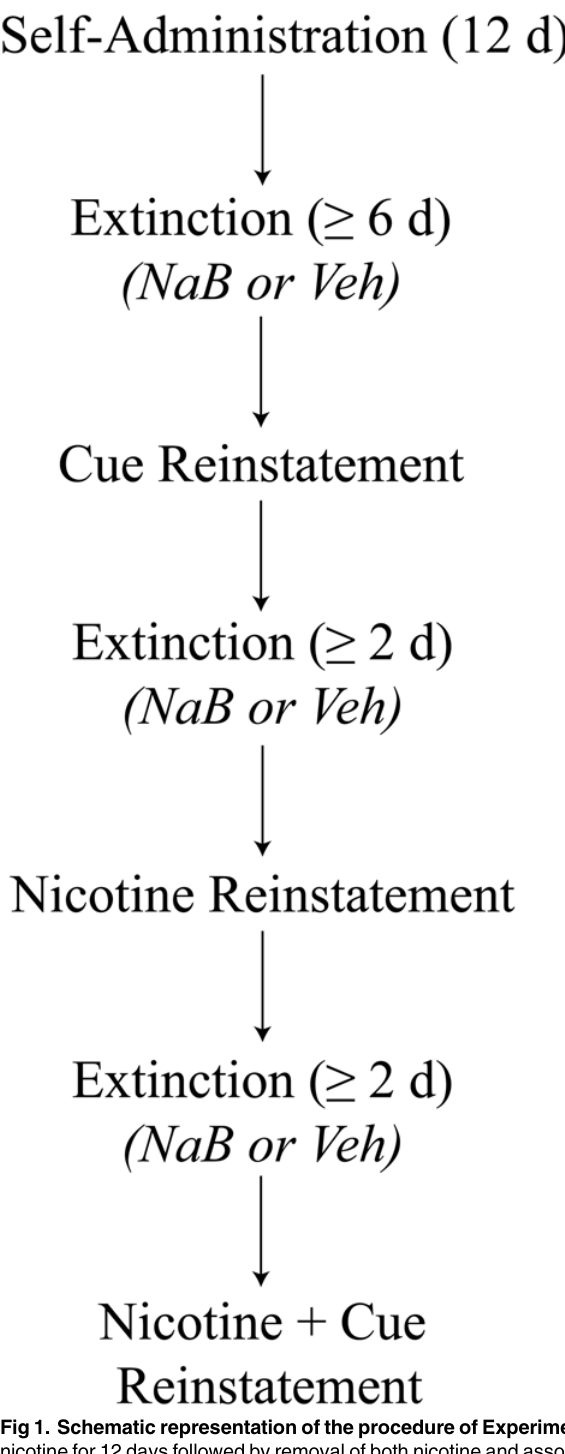
Fig 1. Schematic representation of the procedure of Experiment 1. Rats were trained to self-administer nicotine for 12 days followed by removal of both nicotine and associated cues to extinguish responding. Across a minimum of six extinction sessions, rats were treated with either the HDAC inhibitor, sodium butyrate (NaB; immediately or six hours following each session), or vehicle (Veh). Reinstatement of nicotine- seeking was then assessed through three reinstatement tests, each separated by a minimum of two further extinction